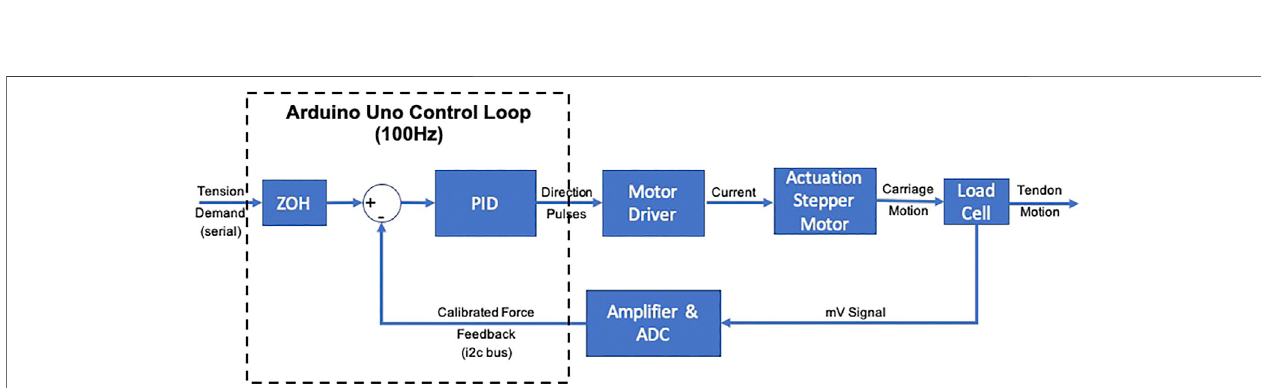
FIGURE 4 | Schematic representation of the closed-loop control for tendon tensioning. The demand is calculated from the model and transmitted to the Arduino UnoandholdviaaZOH.TheControlLooprunsat100 HzandrunsaPIDcontrollerbasedontheerrorbetweenthedemandandtheForceFeedback.Thecontrolsignal are pulses for the Motor driver that generates the current to run the stepper motor. The lead-screw mechanism applies the tension to the tendon via the cantilever load cell. The measurements from the latter are being ampli fi ed and sampled by from the ADC at the rate of the Control Loop.